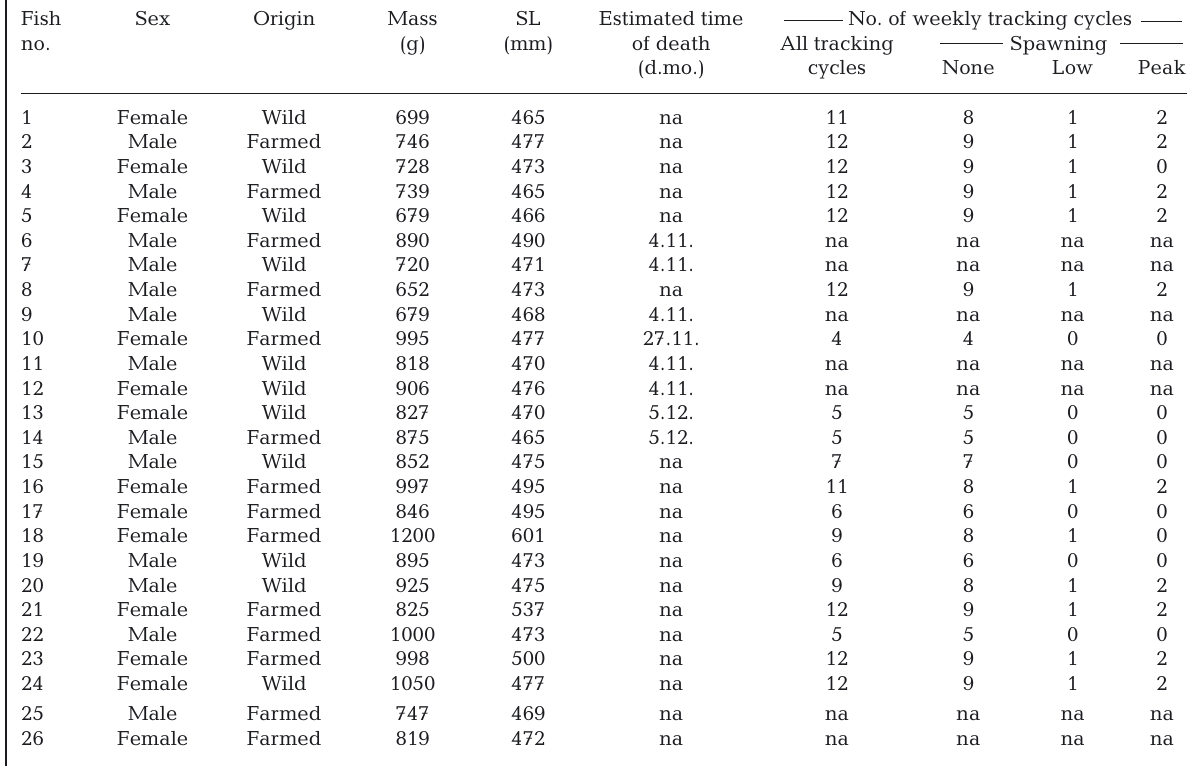
Table 1. Tagged individuals of burbot with their sex, origin, body mass, standard length (SL), estimated time of death and number of weekly tracking cycles (all and during expected spawning intensities). Two individuals (nos. 25, 26) were used to monitor the energy consumption during spawning season in the seminatural channel. na: not